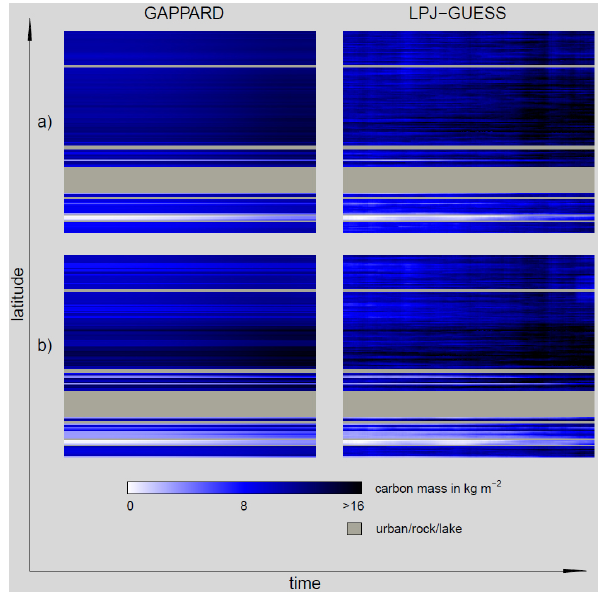
Figure 2. Total carbon mass development along the analyzed tran- sect from 1900 (left side) to 2100 (right side) with LPJ-GUESS (100 stochastic replicates) and using the GAPPARD method. (a) adjusted parameter set; (b) standard parameter